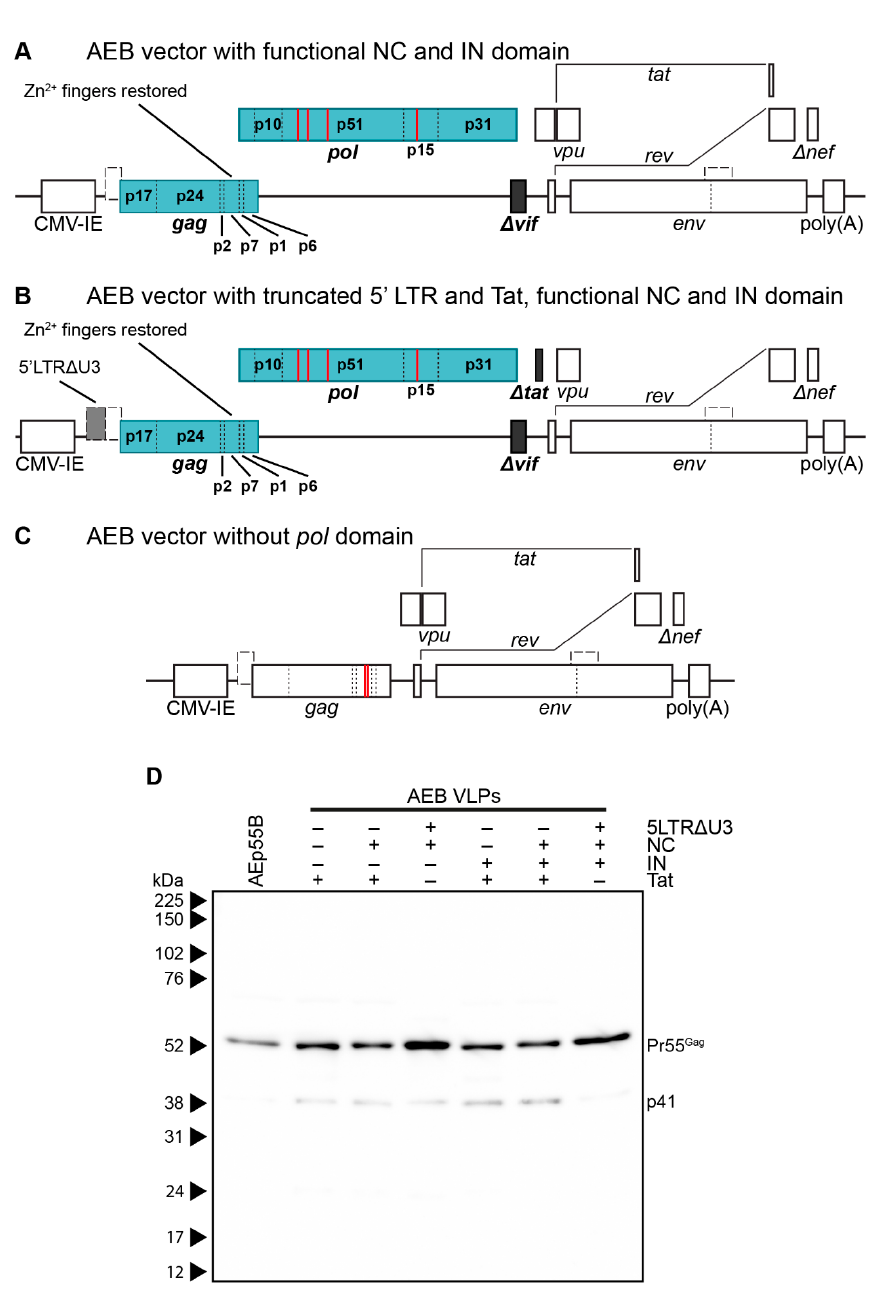
Figure 3. Genetic organization and characterization of VLPs expressing functional RNA binding domains and RNA packaging motifs. ( A ) Schematic representation of the pCMV-AEB.NC.IN expression cassette. ( B ) Schematic representation of the pCMV-5 LTR Δ U3-AEB.NC.IN. Δ tat expression cassette. ( A ) and ( B ) also represent the plasmids pCMV-AEB.NC and pCMV-5 LTR ∆ U3-AEB.NC, respectively, except the IN domain (p31) was absent in these plasmids. ( C ) Schematic